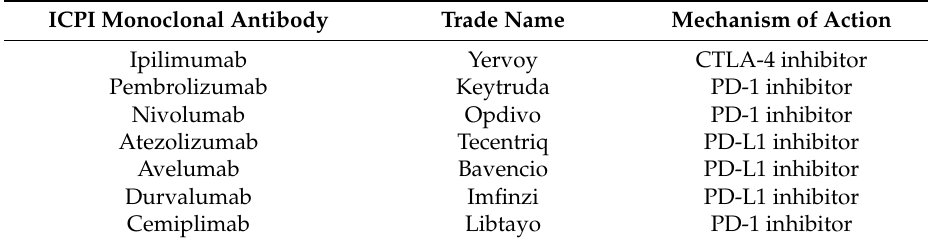
Table 1. Checkpoints inhibitors approved by the Food and Drug Administration (FDA) and the European Medicines Agency (EMA) presented according to the chronological order of introduction into the pharmaceutical market and their mechanism of action.